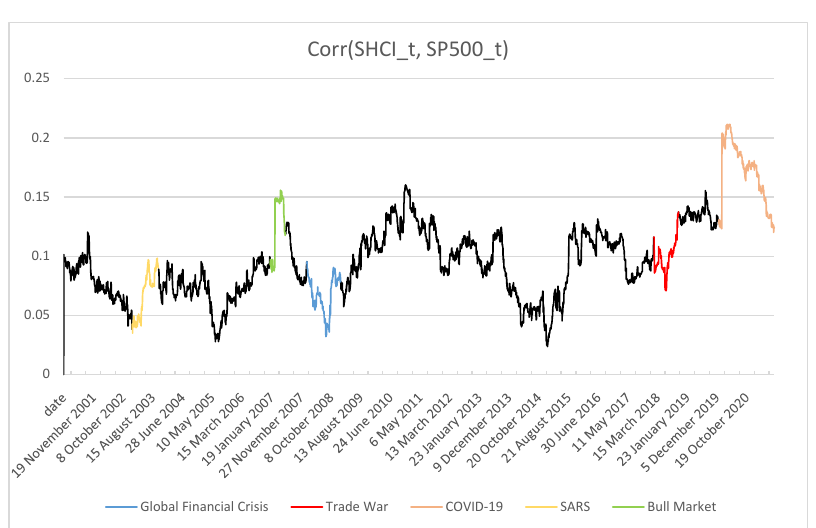
Figure 5. Dynamic correlation between SHCI and SP500